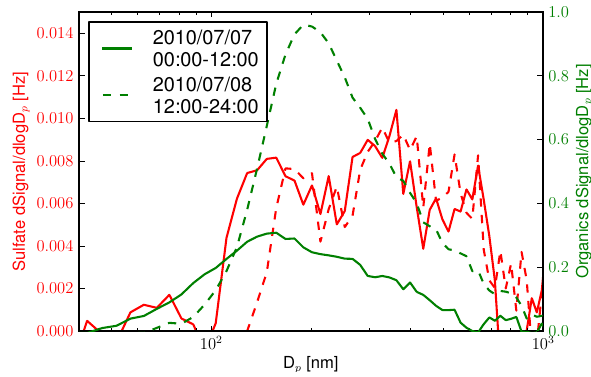
Fig. 10. Measured CCN concentrations at 4 supersaturations (col- ored lines) and CN100, CN150 and CN240 (number concentrations of particles larger than 100, 150 and 240nm, respectively; black lines) at Raven’s Nest versus time.